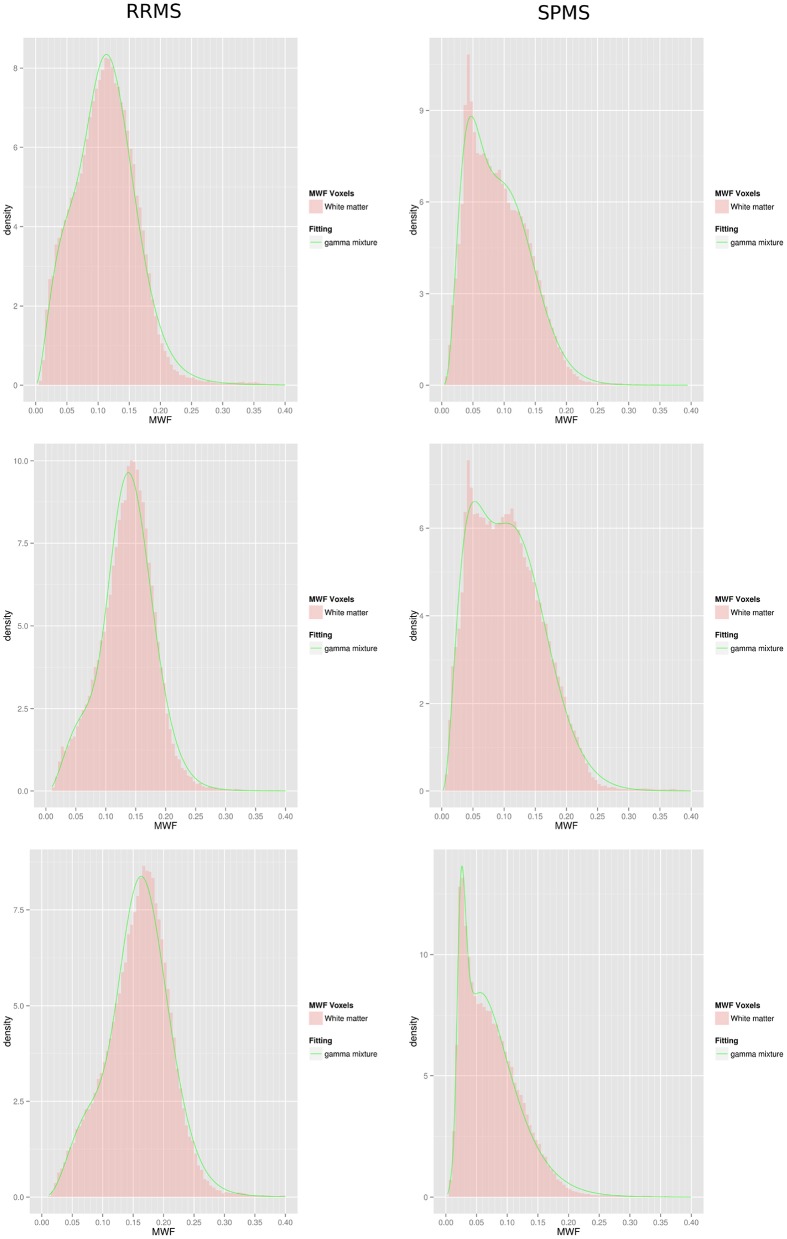
Gamma mixture fits of 3 RRMS subjects (left column) and 3 SPMS subjects (right column). Histograms are only represented for illustrative purposes and were not used during the fitting procedure.